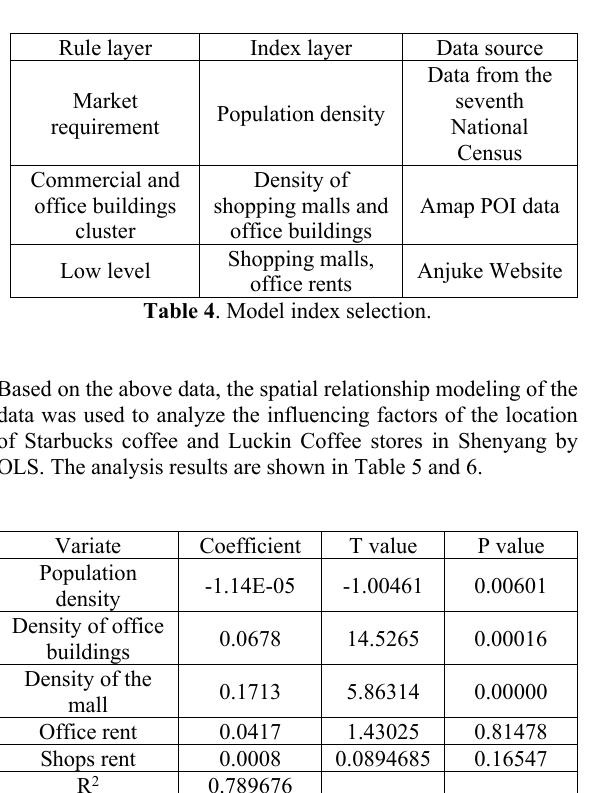
Table 5 . OLS regression results of Starbucks coffee store density in Shenyang.